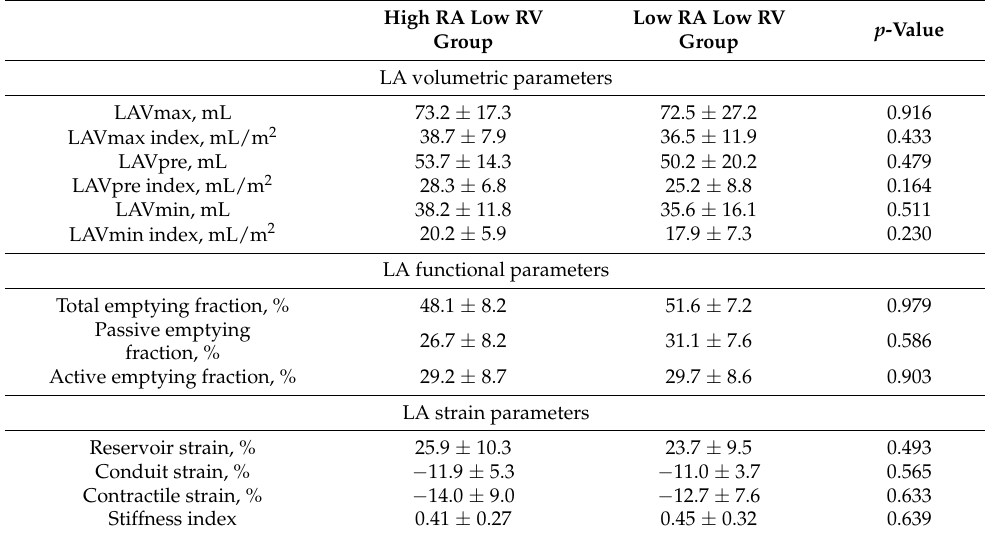
Table 2. Baseline parameters based on high and low atrial pacing, low right ventricular pacing.